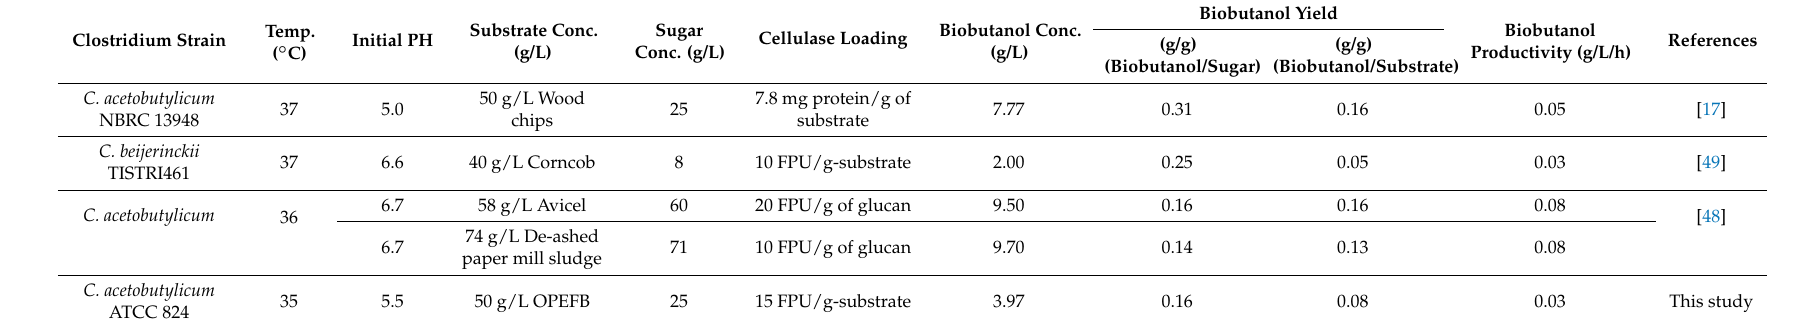
Table 6. Comparison studies of biobutanol production through SSF process from various